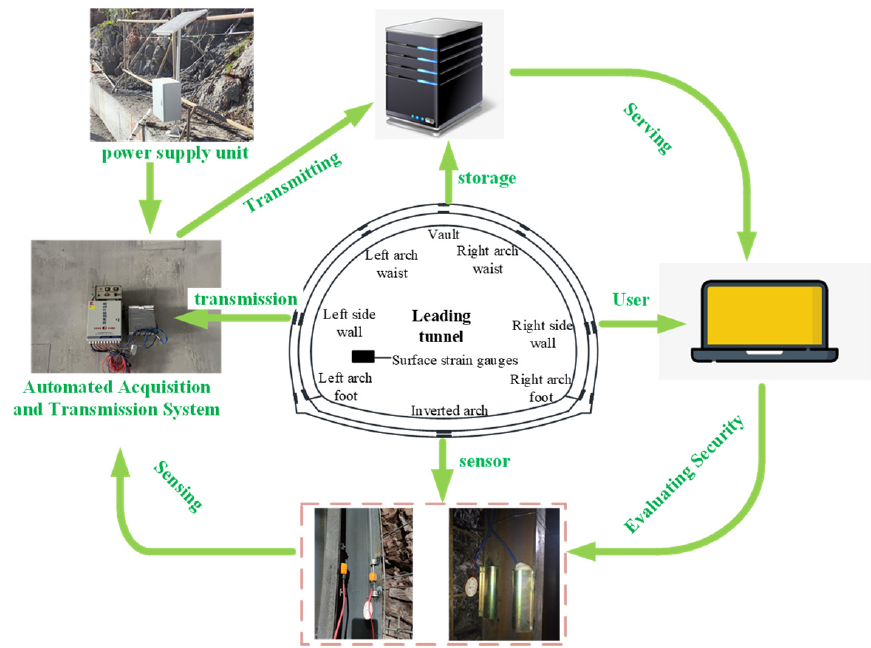
Figure 5. Monitoring points and automation system workflow.